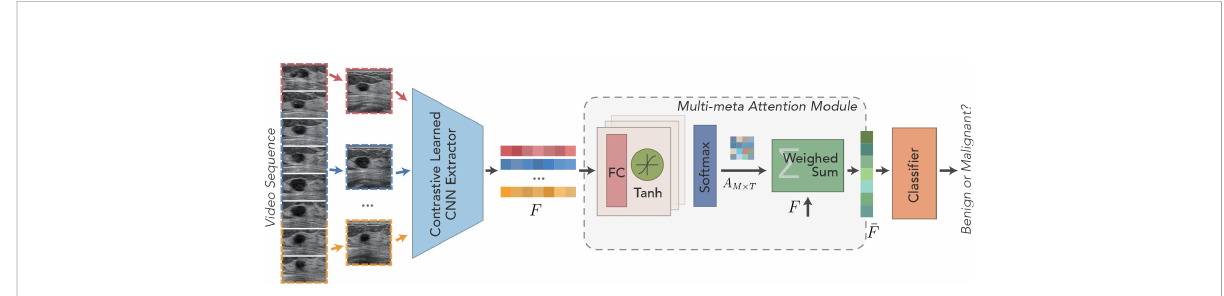
FIGURE 1 Schematic illustration of the developed Contrastive Learning guided Multi-meta Attention Network (CLMAN) for breast lesion classi fi cation in ultrasound